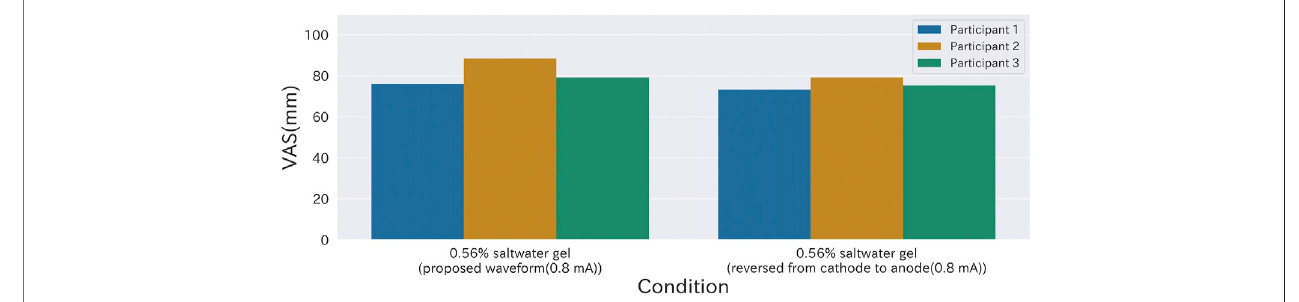
FIGURE 8 | Evaluation results of saltiness intensity in preliminary study 1. The bar graph shows the average value of the evaluation of each condition for each participant.